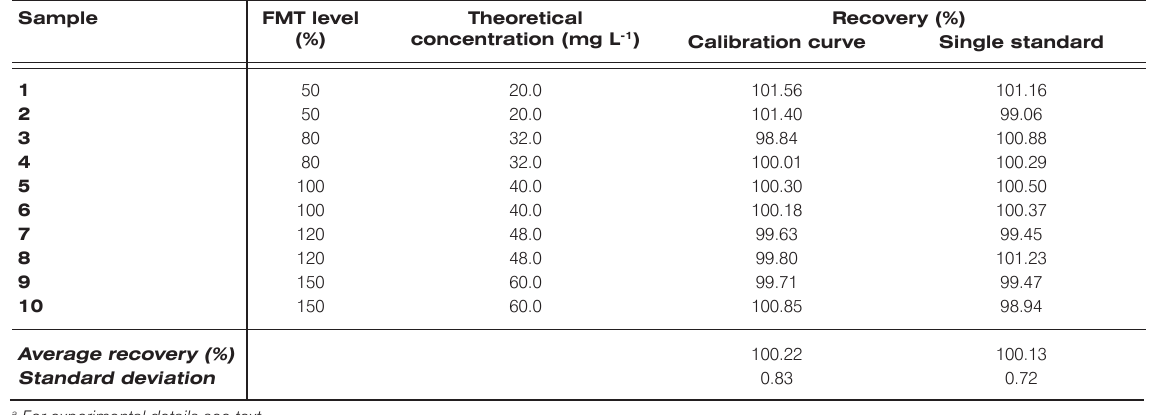
Table 2. Within-day accuracy of the HPLC method a